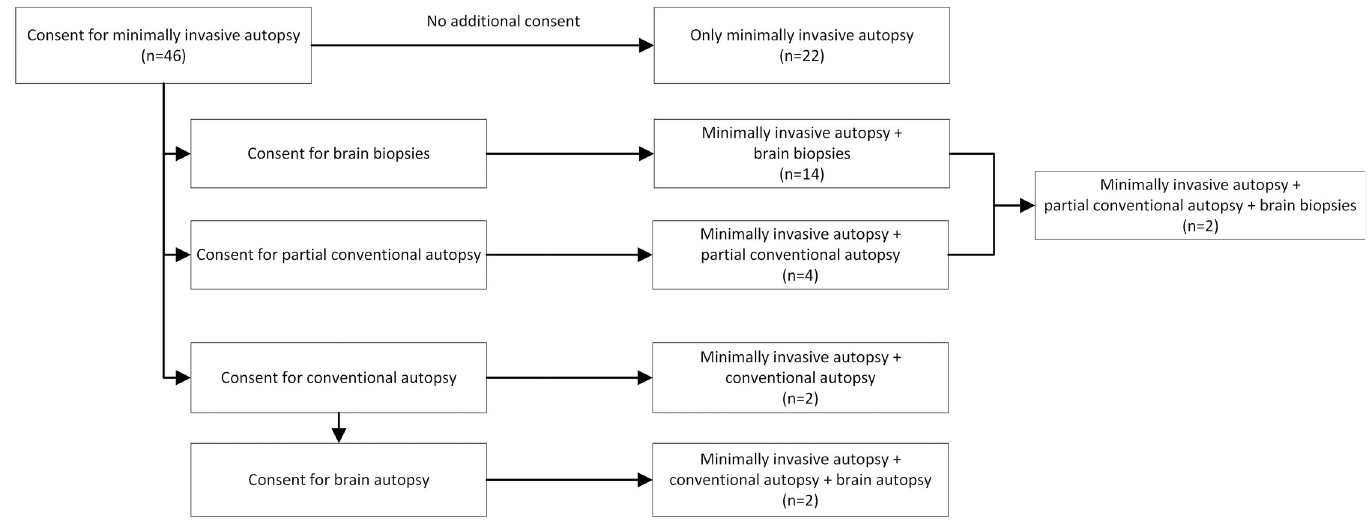
Fig 2. Case inclusion